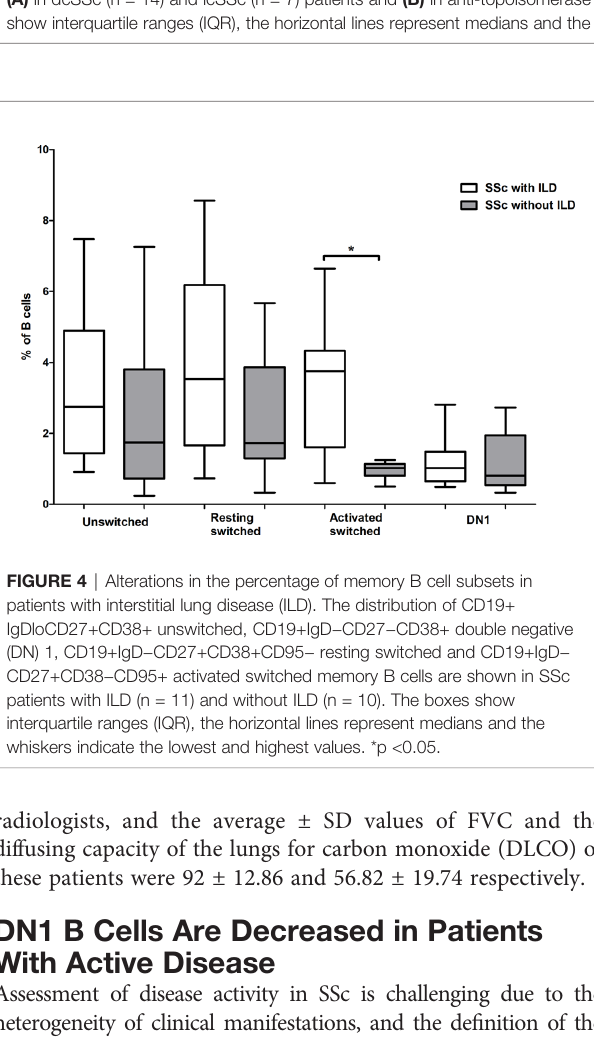
FIGURE 3 | Differences in the frequency of memory B cell subsets in de fi ned subgroups of SSc. CD19+IgDloCD27+CD38+ unswitched, CD19+IgD − CD27 − CD38+ double negative (DN) 1, CD19+IgD − CD27+CD38+CD95- resting switched and CD19+IgD − CD27+CD38 − CD95+ activated switched memory B cells were analyzed